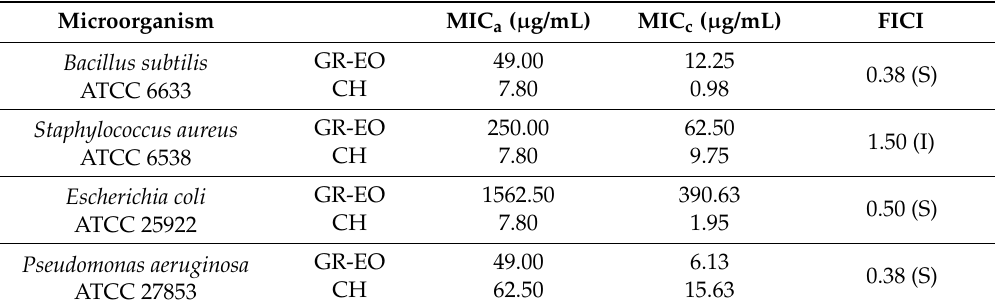
Table 3. Fractional inhibitory concentrations indices (FICIs) of Chloramphenicol combined with GR-EO against tested bacterial strains.